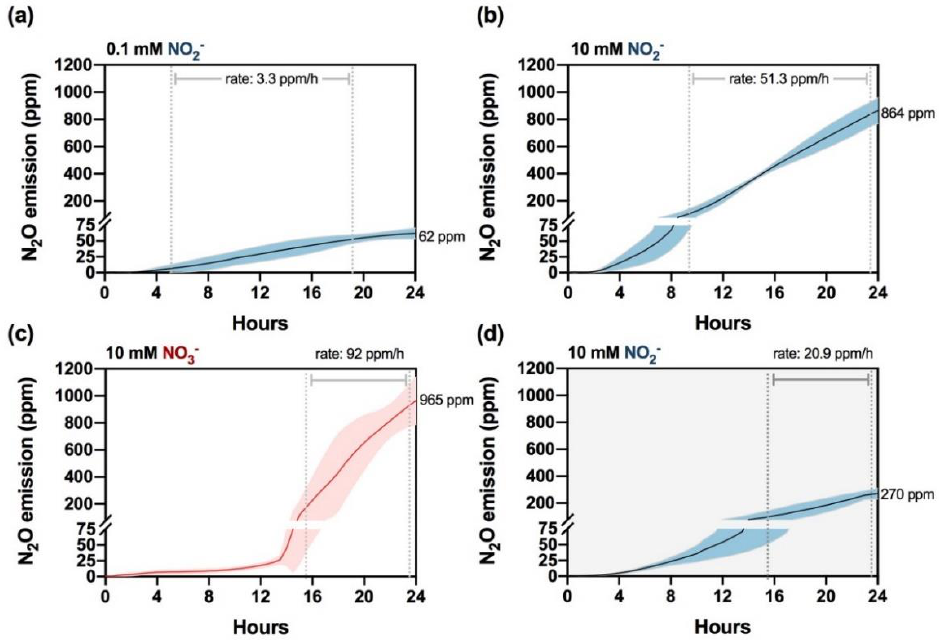
Figure 2. Kinetics of N 2 O emission in the M3 strain in the presence of NO 3 − and NO 2 − . NH 4+ -grown cells were washed and transferred to NO 2 − -containing media in sealed bottles at 0.1 mM ( a ) and 10 mM ( b ) in the light. Cells were also incubated in the presence of 10 mM NO 3 − under illumination ( c ) and 10 mM NO 2 − in the dark ( d ). Each data line represents an average of three biological replicates, and the colored area corresponds to ±SD.